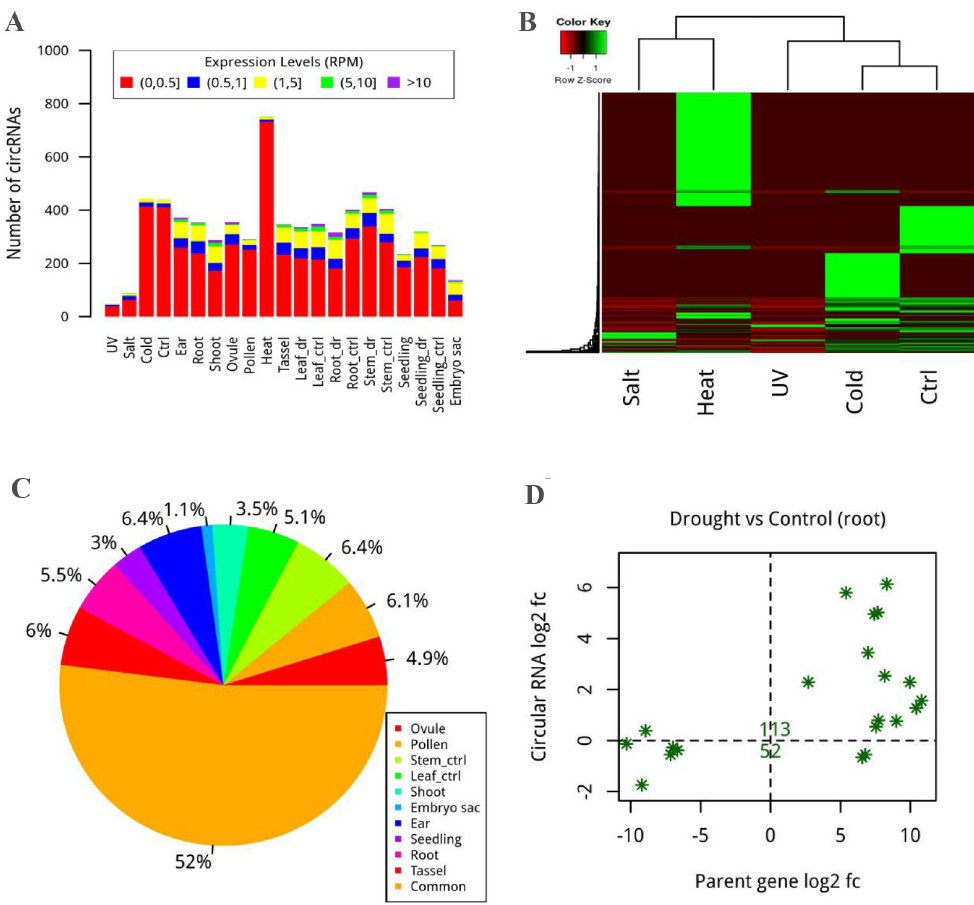
Fig 4. Expression pattern of circRNAs. (A) Expression level of circRNAs in different scopes. CircRNAs were usually expressed at lower levels, which may explain their difficult detection because they lack a poly(A) tail. ctrl and dr indicate control and drought, respectively. (B) The degree of circRNA expression under five different treatments was shown by heatmap. More circRNAs were present under heat stress. (C) Pie chart with rainbow colours showing the ratio of circRNAs possessing tissue-specific expression in 10 different tissues. (D) Tendency for differential expression of circRNAs and the overlapping genes was plotted using fold changes between the drought and control in root as the standard. The number of both differentially expression circRNAs and genes is